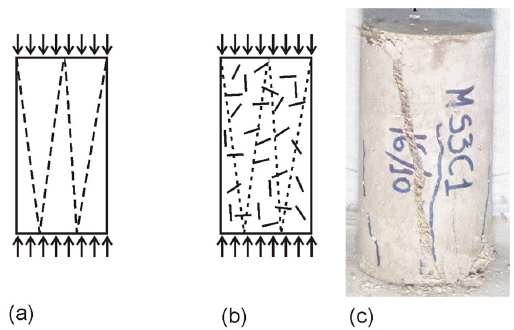
Figure 5. Rupture mechanism under compression: (a) matrix; (b) effect of fibre reinforcement; c) typical fracture mode of the